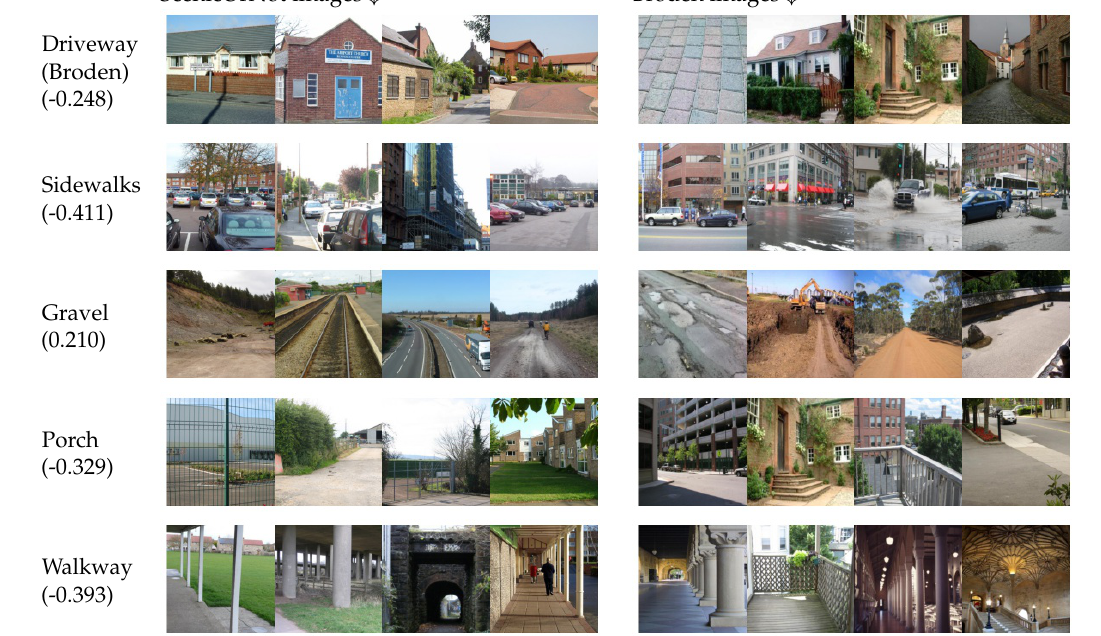
Figure 13. Closest images for driveway, a concept that has been trained with visual examples from Broden (top row) and its corresponding neighboring concepts from GloVe. Each concept shows its correlation with scenicness in the latent